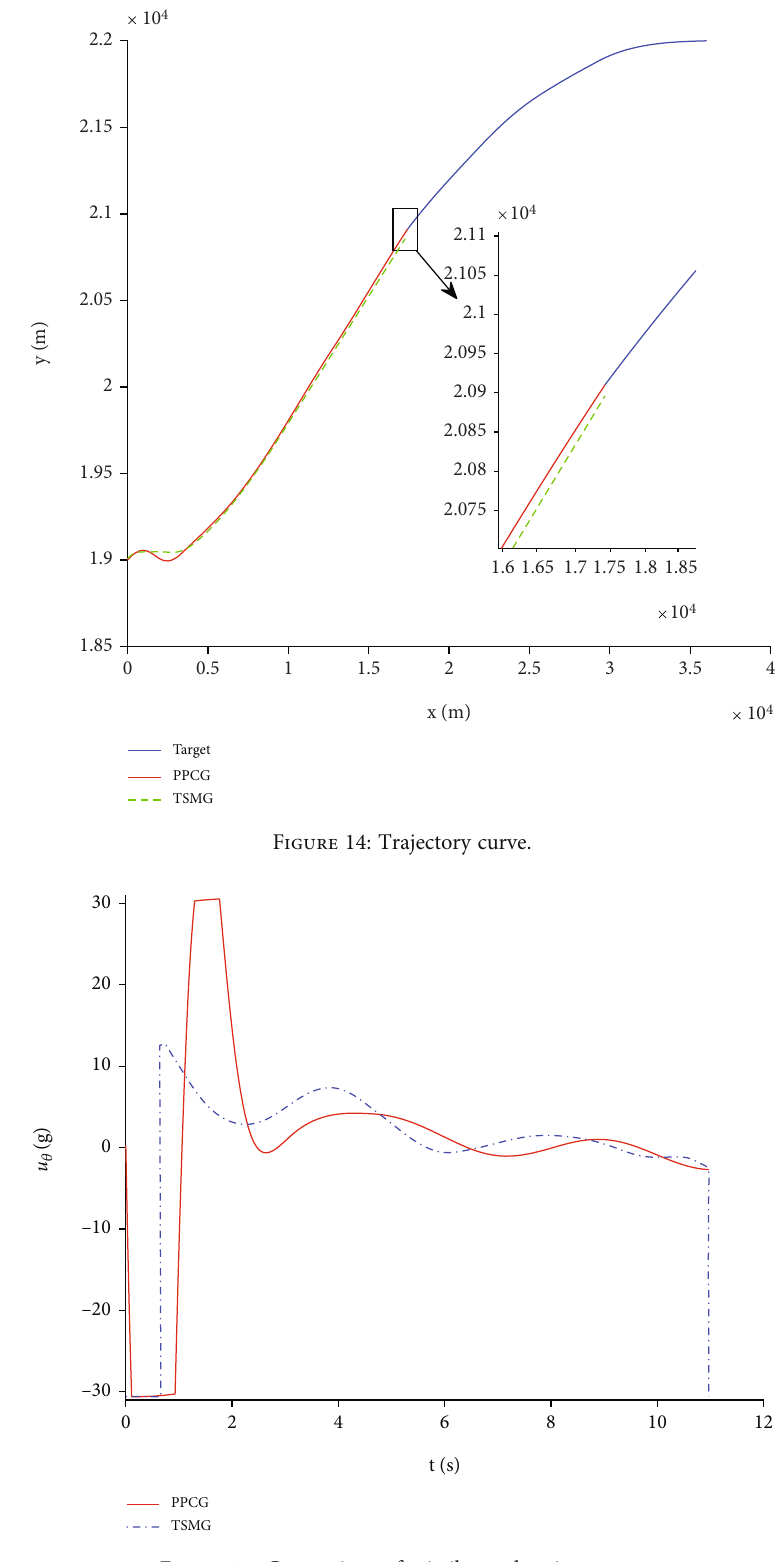
Figure 15: Comparison of missile acceleration